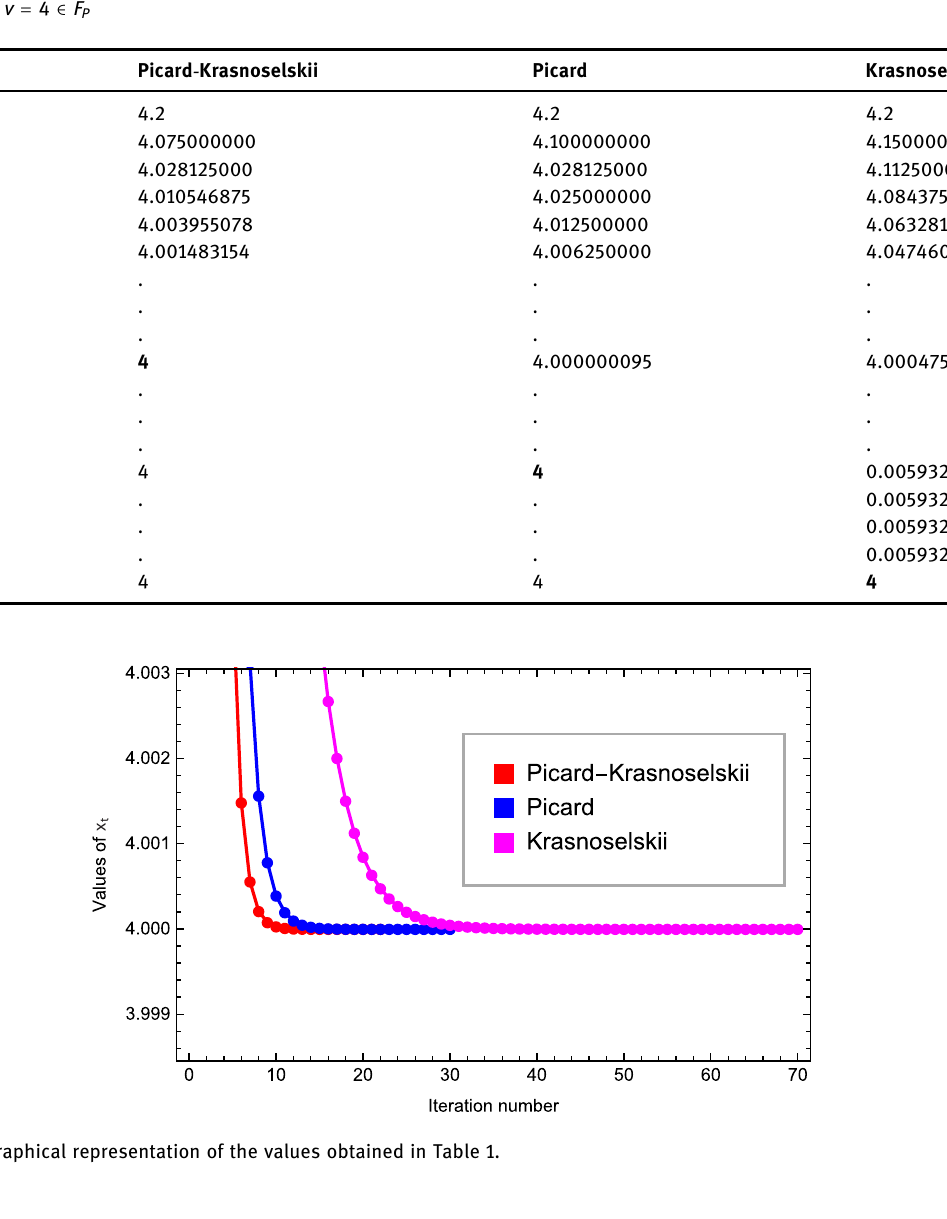
Table 1: Numerical results obtained from Picard - Krasnoselskii hybrid, Picard and Krasnoselskii iterative schemes to an element = ∈ v